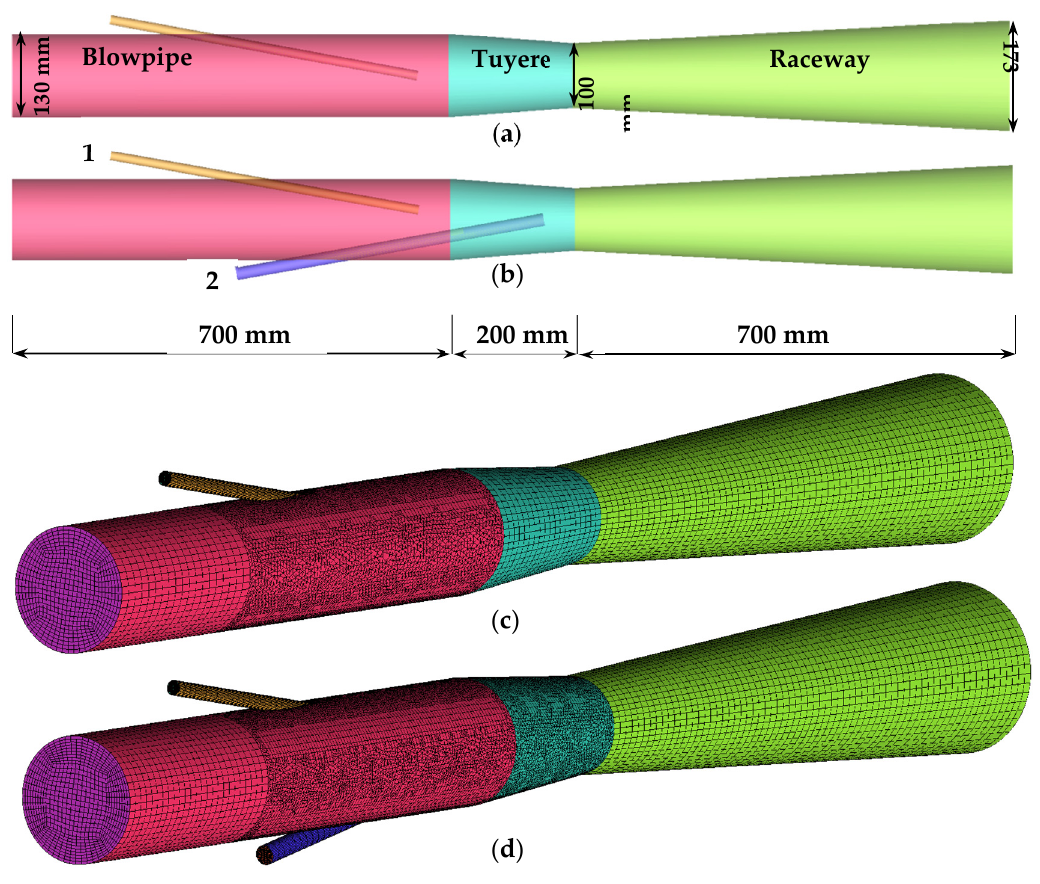
Figure 1. Geometry and mesh: ( a ), ( c ) base case; and ( b ), ( d ) targeted oxygen enrichment. Table 2. Boundary conditions and operating